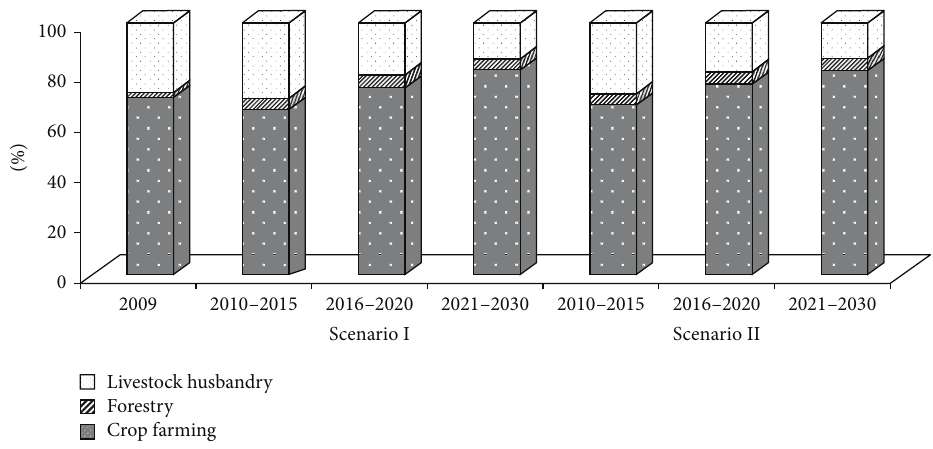
Figure 5: Proportion of crop farming, forestry, and livestock husbandry